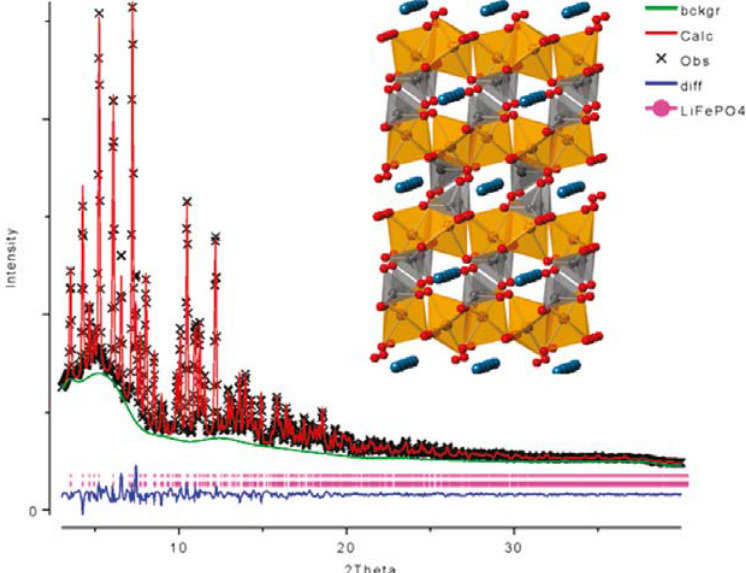
Figure 1. High-resolution synchrotron X-ray diffraction (XRD) and Rietveld refinement patterns from hydrothermally prepared LiFePO